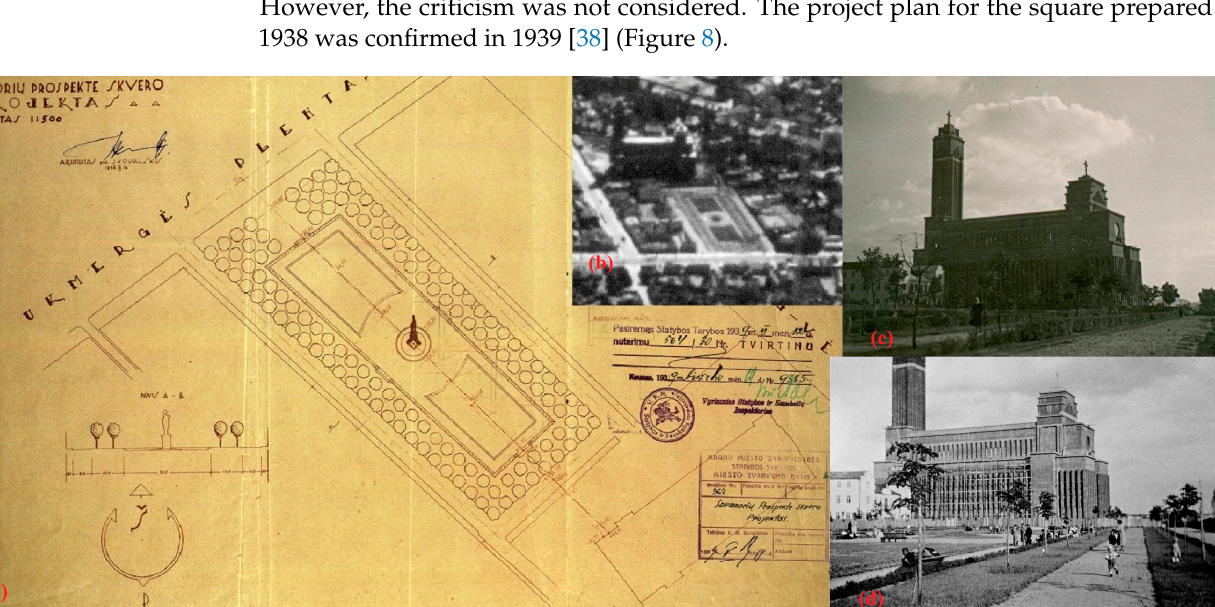
Figure 7. Christ’s Resurrection Church. View from the city’s lower terrace. ( a )1930s (source: Kaunas City Museum); ( b ) 1960s (photographer Stanislovas Lukošius, source: Kaunas City Museum); ( c ) 2020 (photo courtesy of Arvydas Pakštalis).